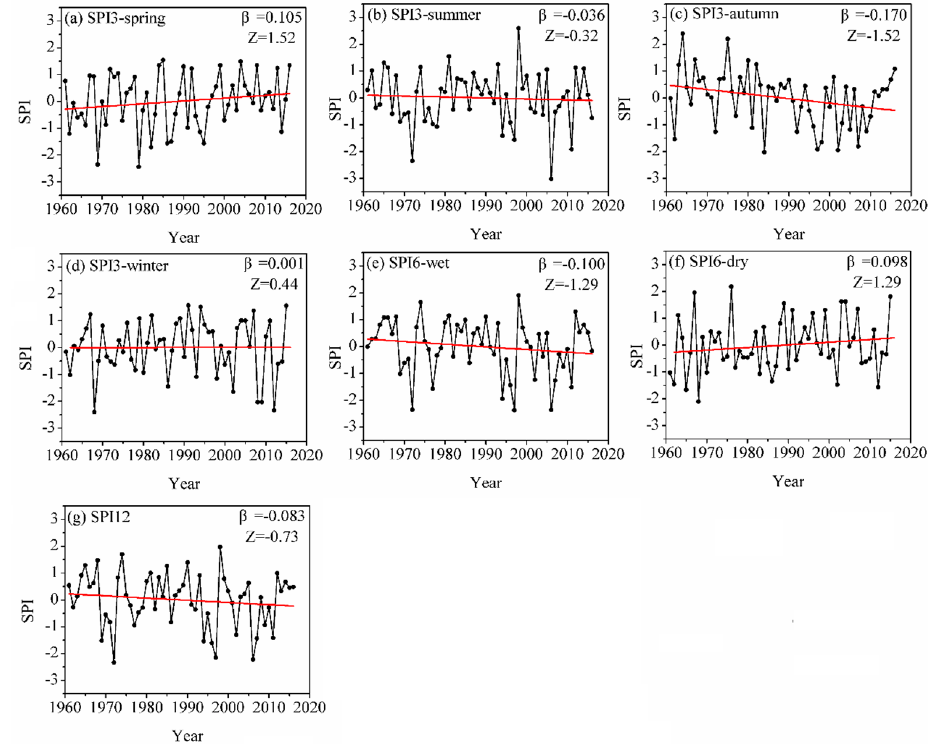
Figure 3. Regional average series for SPI in Sichuan Province during 1961–2016. The red line represents the slope of the datasets during 1961–2016 ( a – d ) for SPI3, ( e , f ) for SPI6, and ( g ) for SPI12.